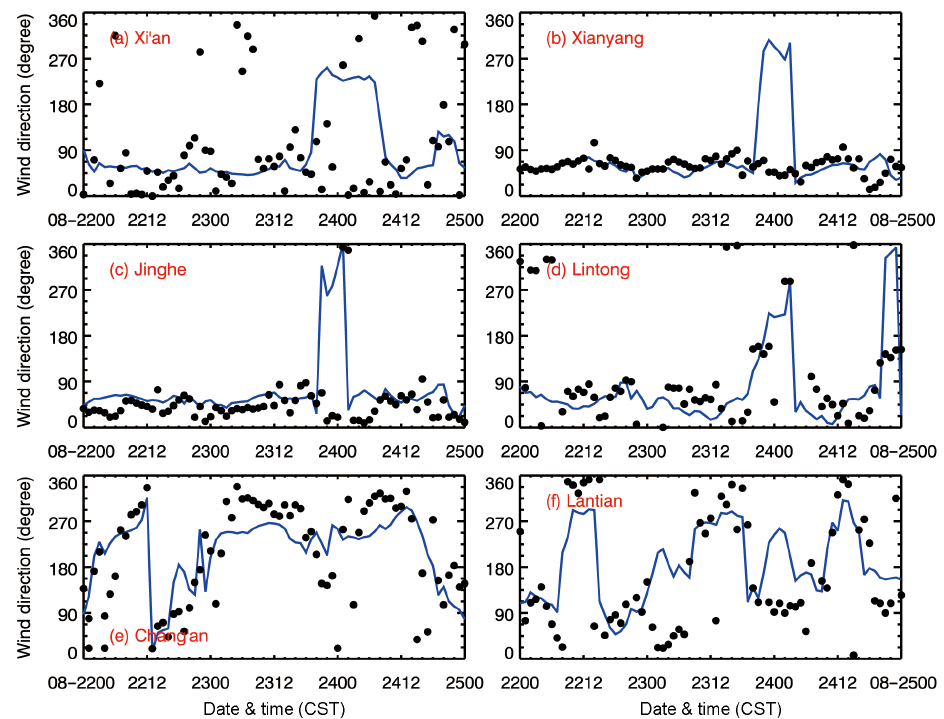
Figure 7. Same as Fig. 6 but for surface wind directions.